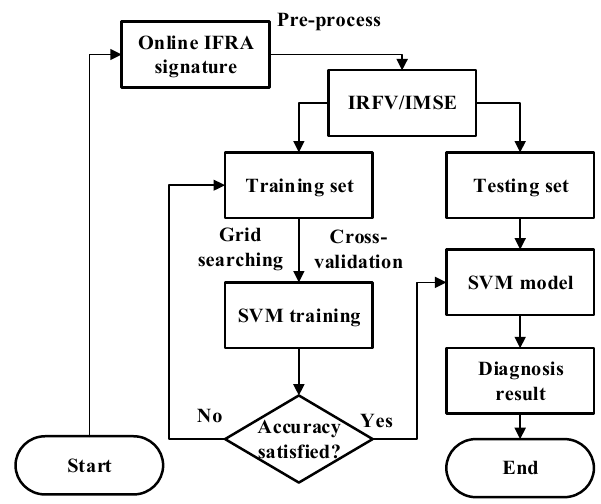
Figure 7. Process of fault diagnosis by support vector machine (SVM).